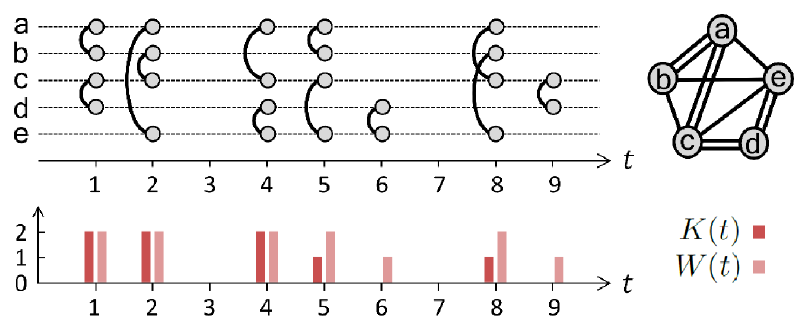
Fig 1. An example of a temporal network in discrete time. The time-resolved and time-aggregated representations of the network (top) and the network-level time series of { K ( t )} and { W ( t )} (bottom). Here W ( t ) and K ( t ) denote the number of activated links and the number of newly activated links at the time step t ,